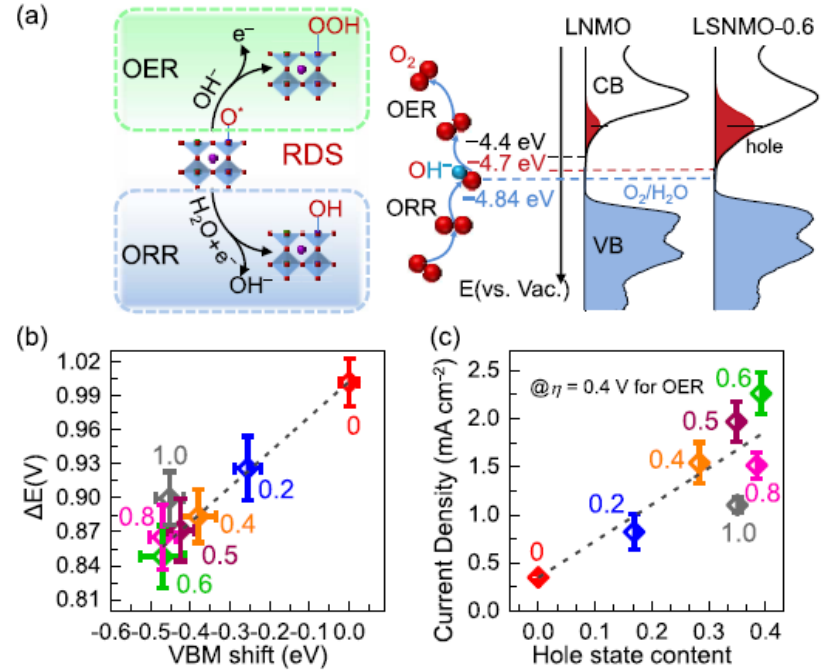
Figure 9. ( a ) Left panel: rate-determining step (RDS) of the OER (the formation of the O − O bond in the OOH – adsorbate) and the ORR (OH – regeneration on the transition metal site). Right panel: schematics diagram for the electronic structure near Ef at the vacuum level scale at pH = 14; the CBM level for LNMO is at −4.4 eV and the redox level for O 2 /H 2 O is located at −4.84 eV. ( b ) ΔE values as a function of VBM shift. ( c ) Current densities at an overpotential of 0.4 V for the OER as a function of hole state content. Copyright 2021 by the American Chemical Society [74].